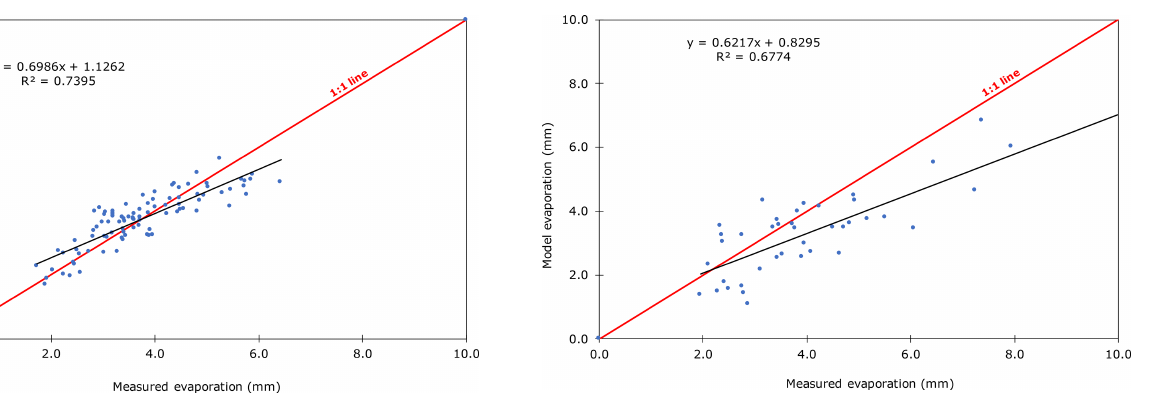
Figure 10. Modelled daily evaporation ( E Res ) versus measured daily evaporation ( E EC ) from June to September 2014.